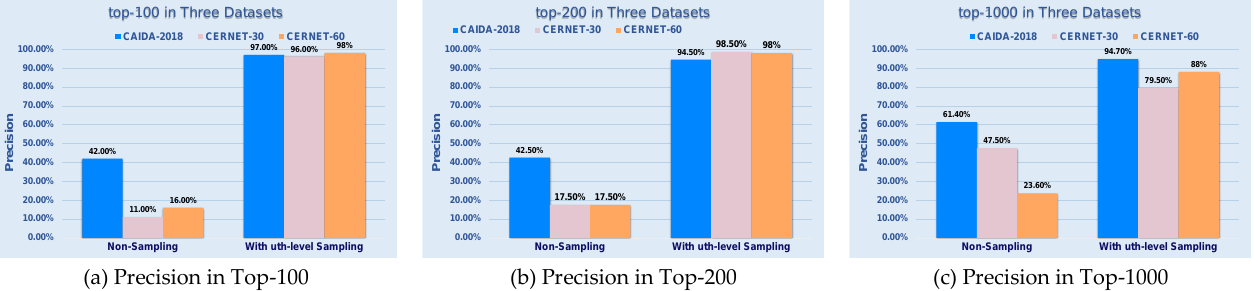
Figure 11. Experiments verifying contribution of key technique. ( a ) Precision in top-100. ( b ) Precision in top-200. ( c ) Precision in